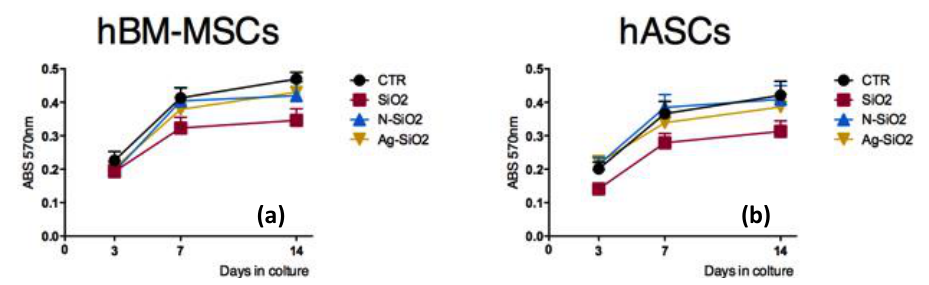
Figure 2. Stem cell viability on surfaces of SiO 2 , N-SiO 2 , and Ag-SiO 2 nanoparticles: ( a ) (3-(4,5-Dimethylthiazol-2-yl)-2,5-Diphenyltetrazolium Bromide (MTT) viability assay of human bone marrow-mesenchymal stem cells (hBM-MSCs) on different nanoparticles at 3, 7, and 14 days; ( b ) MTT viability assay of hASCs on different nanoparticles at 3, 7, and 14 days.